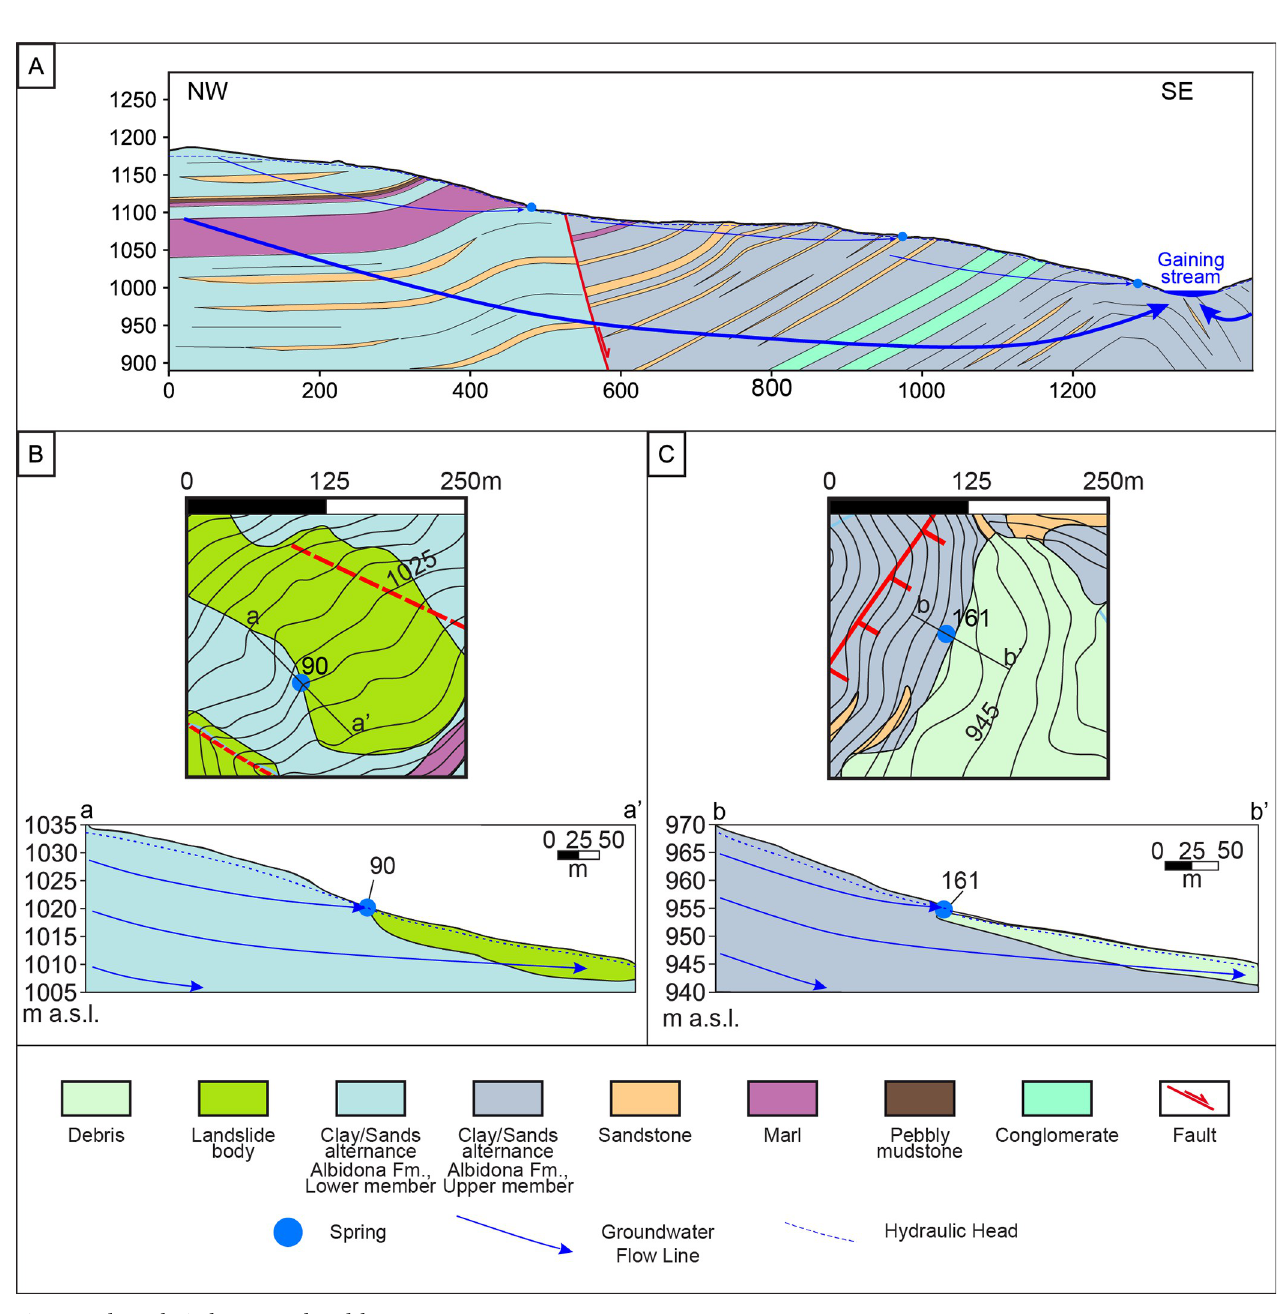
Fig 15. Hydrogeological conceptual